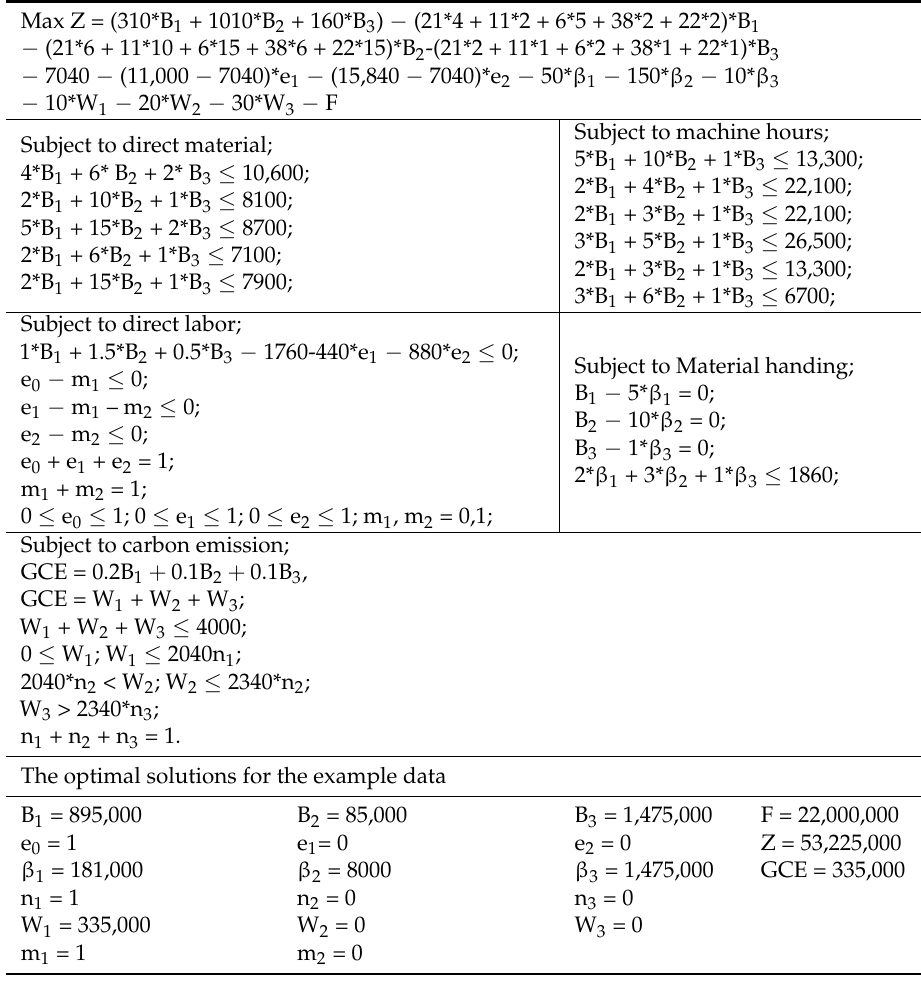
Table 2. The model and its optimal solutions with the illustrative data for Model 1.